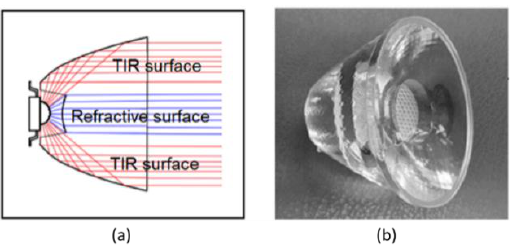
Figure 3. Illustration of collimator using in this research: ( a ) Principles of Total Internal Reflection (TIR) lens; ( b ) A commercial collimator lens.